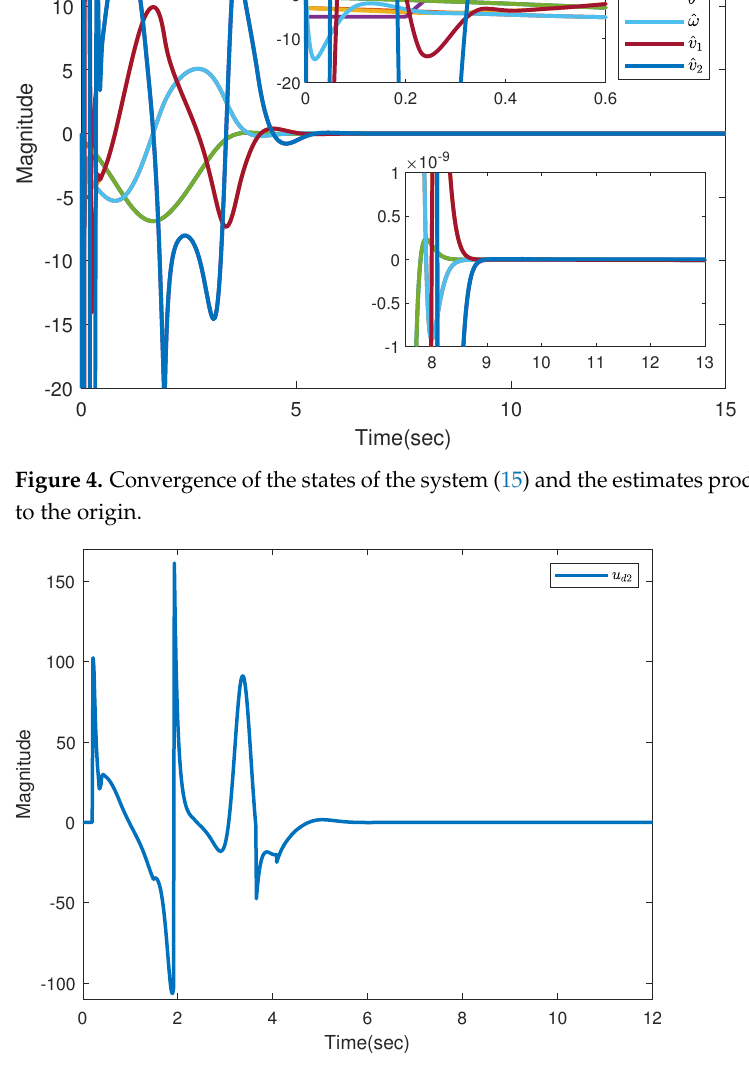
Figure 5. Time history of the control input u d 2 based on the estimates produced by the observer